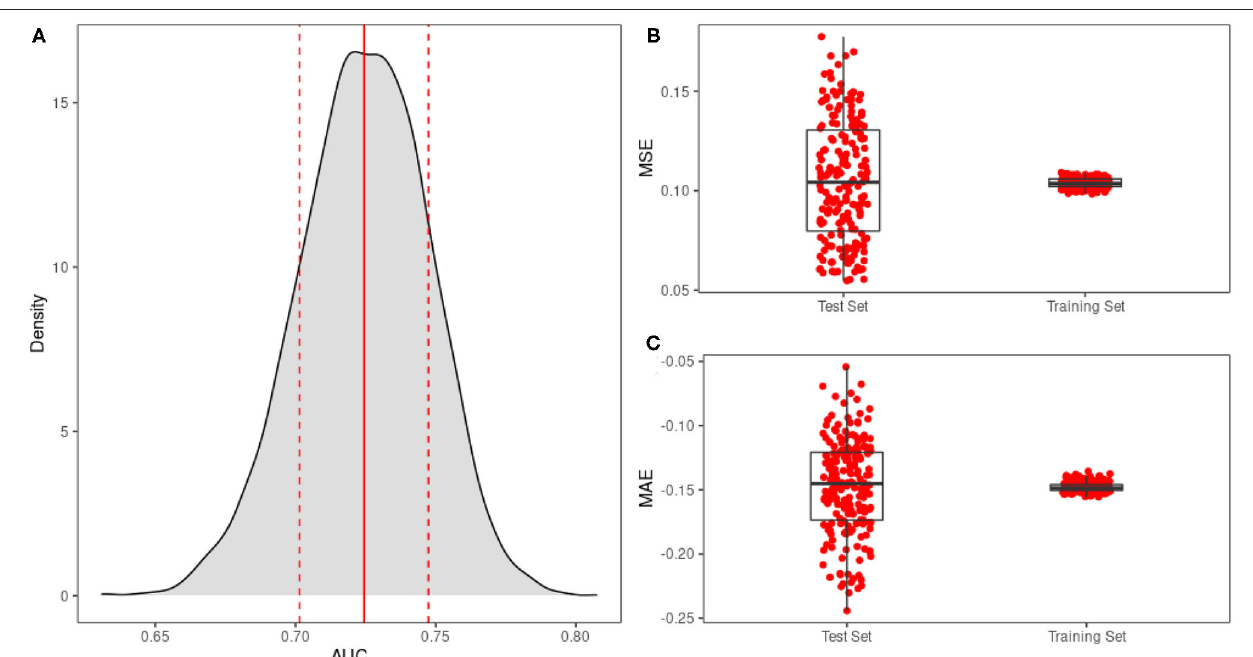
FIGURE 2 | (A) The distribution of AUC values for 4,000 draws from the posterior distribution, where the solid line represents mean AUC, and dashed lines represent 1 standard deviation. Also shown are the distributions of (B) mean square error (MSE) values and (C) mean absolute error (MAE) values from repeated k -fold